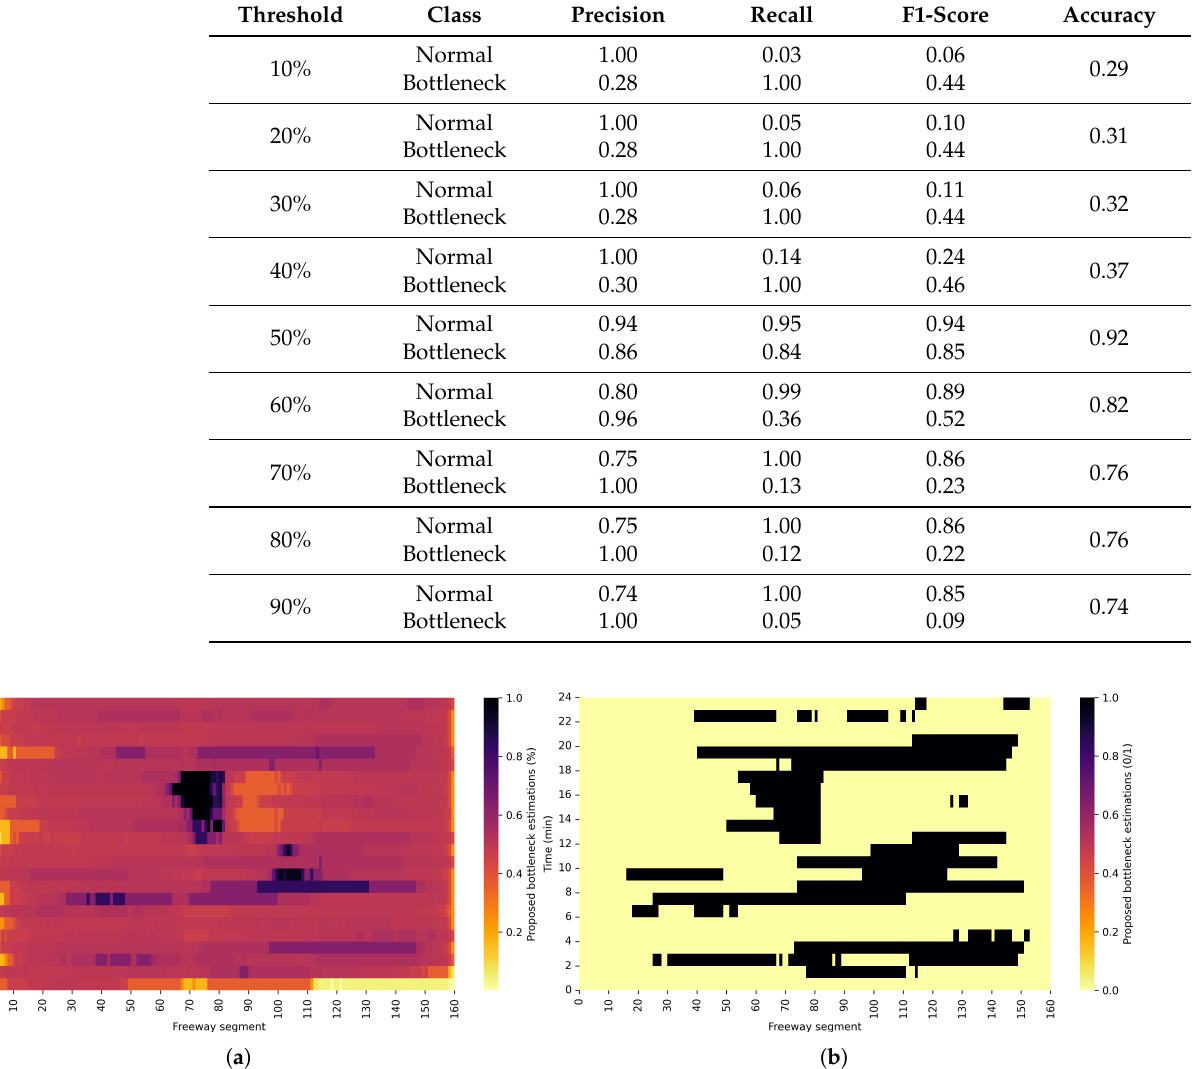
Figure 9. Proposed method for the bottleneck probability. ( a ) Estimated bottleneck probability exact values; ( b ) Binary image where 1 represent